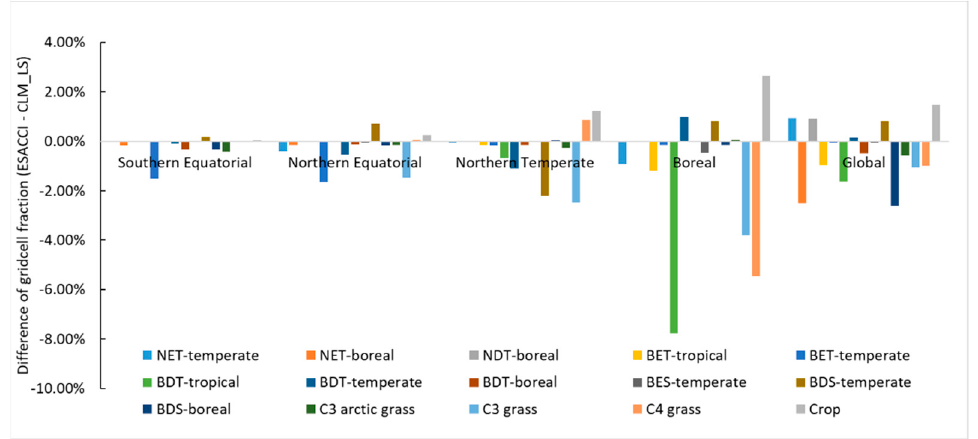
Figure 2. The difference in the PFTs’ coverage between ESACCI and CLM_LS.